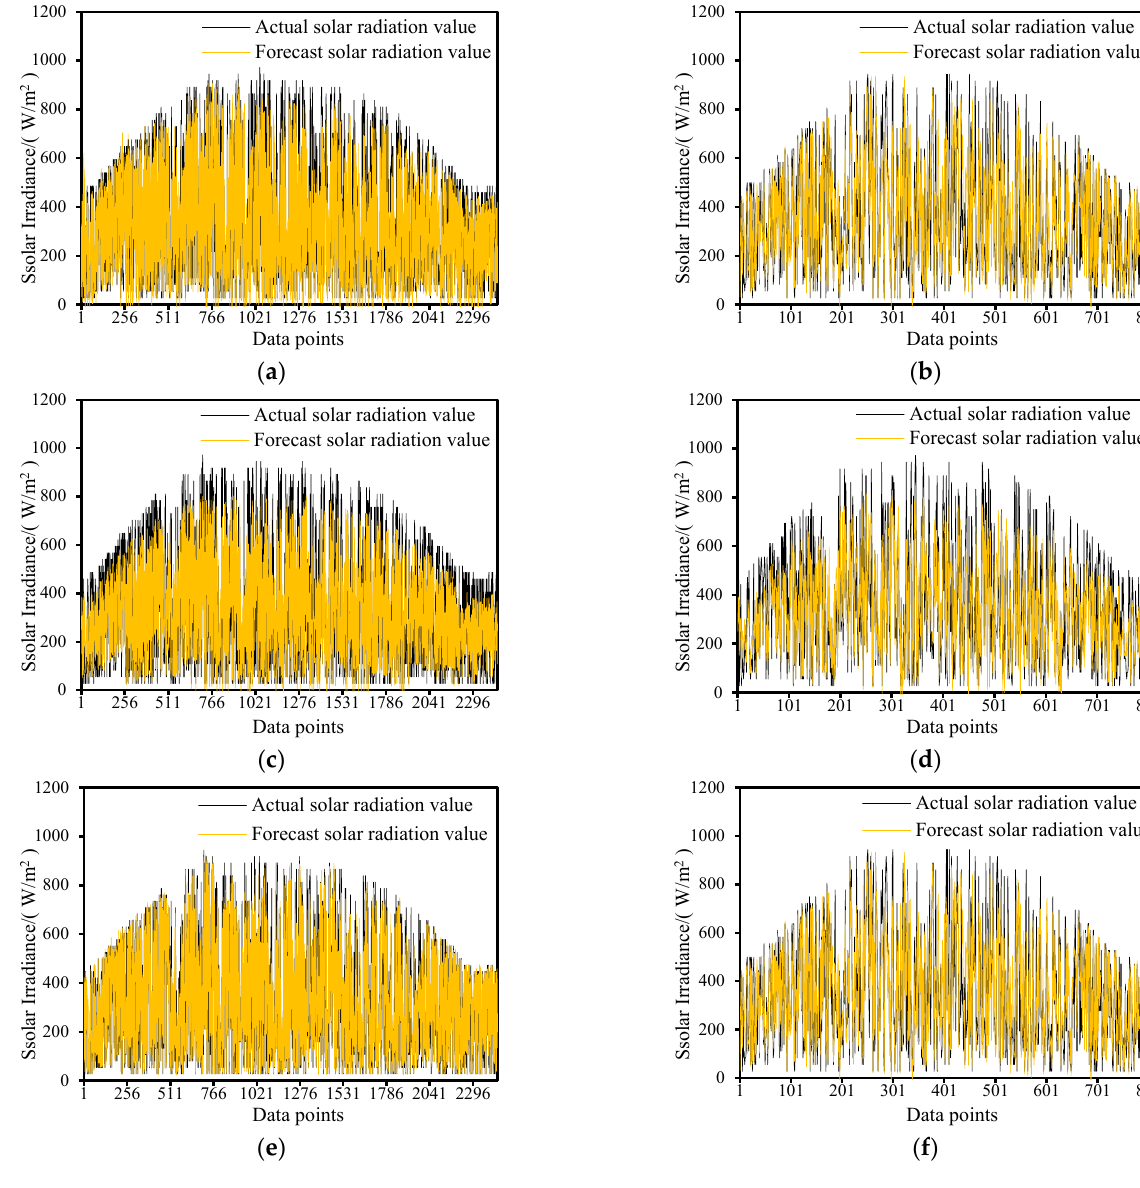
Figure 7. Prediction results of three models. ( a ) Training set of BP. ( b ) Testing set of BP. ( c ) Training set of SVR. ( d ) Testing set of SVR. ( e ) Training set of LightGBM. ( f ) Testing set of LightGBM.